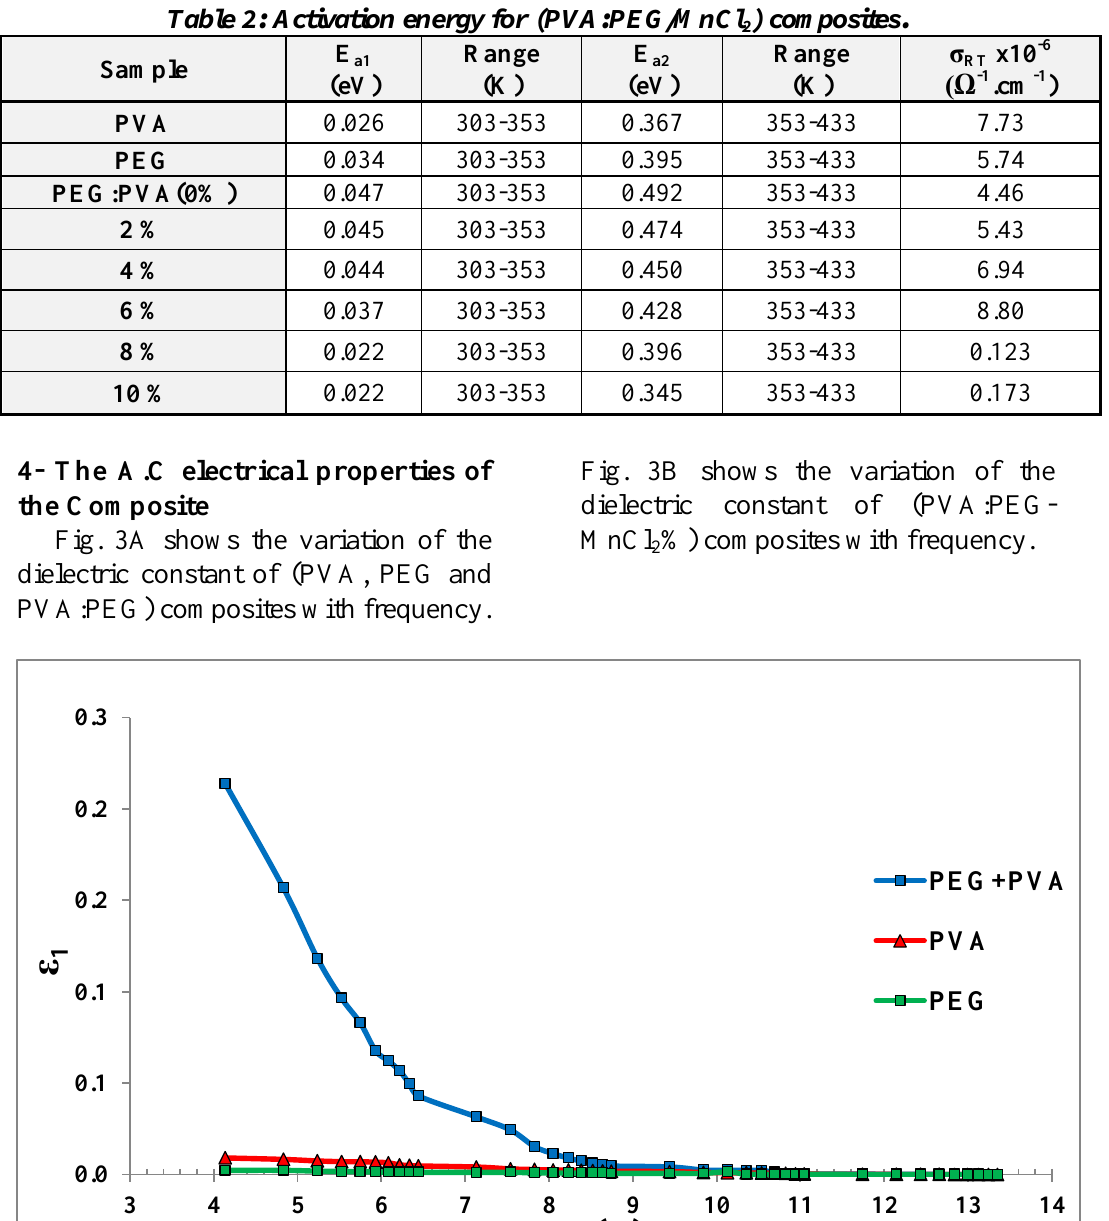
Table 2: Activation energy for (PVA:PEG/MnCl